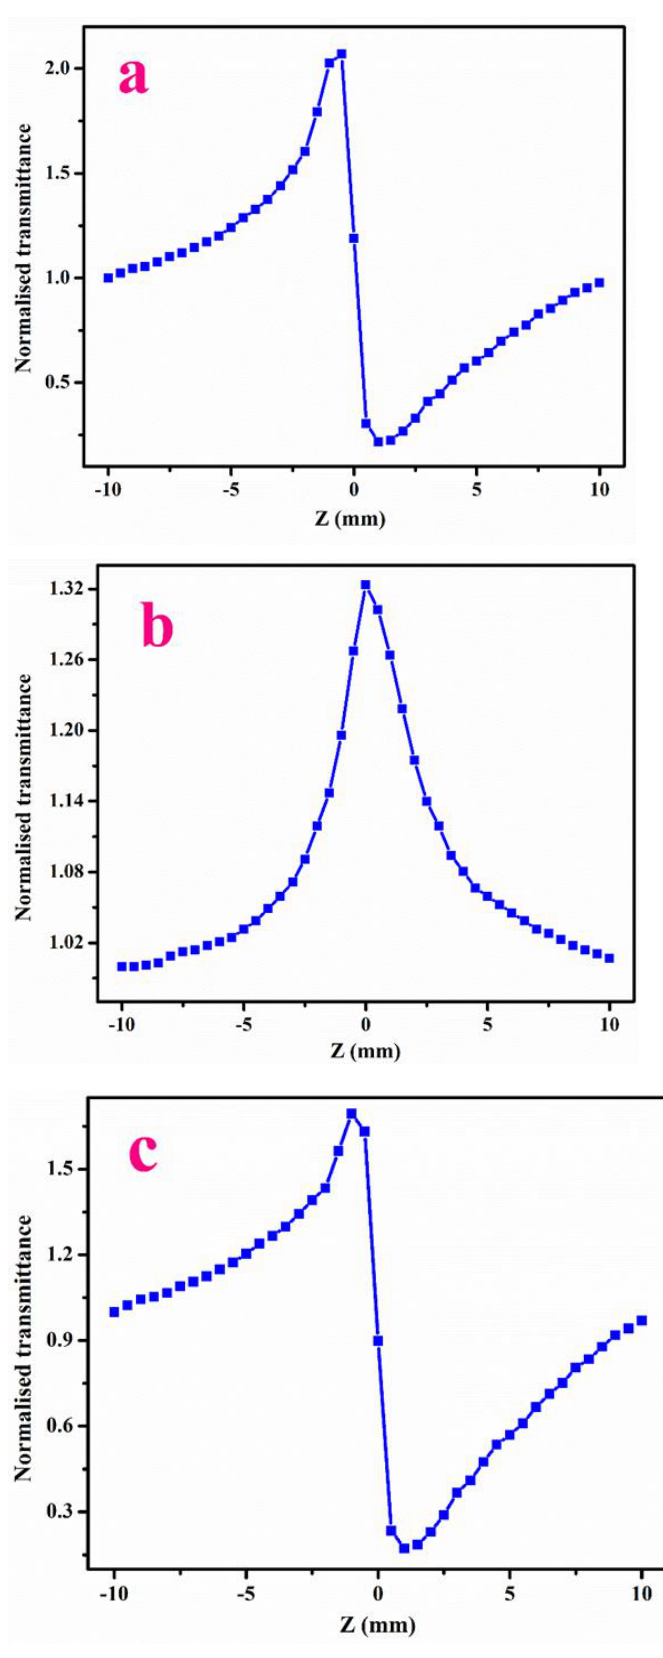
Figure 9. ( a ) Closed aperture and ( b ) Open aperture ( c ) Ratio of the closed-to-open Z-scan traces of